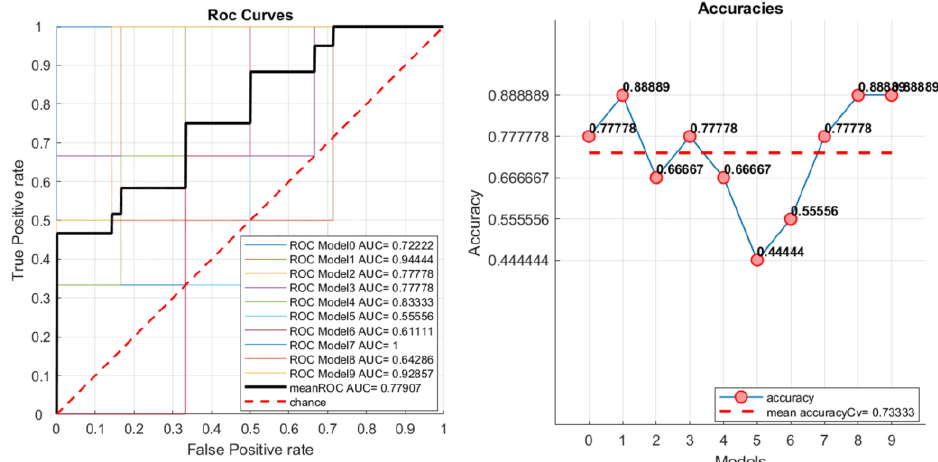
Figure 5. Example of ROC curves, AUCs, and accuracies.